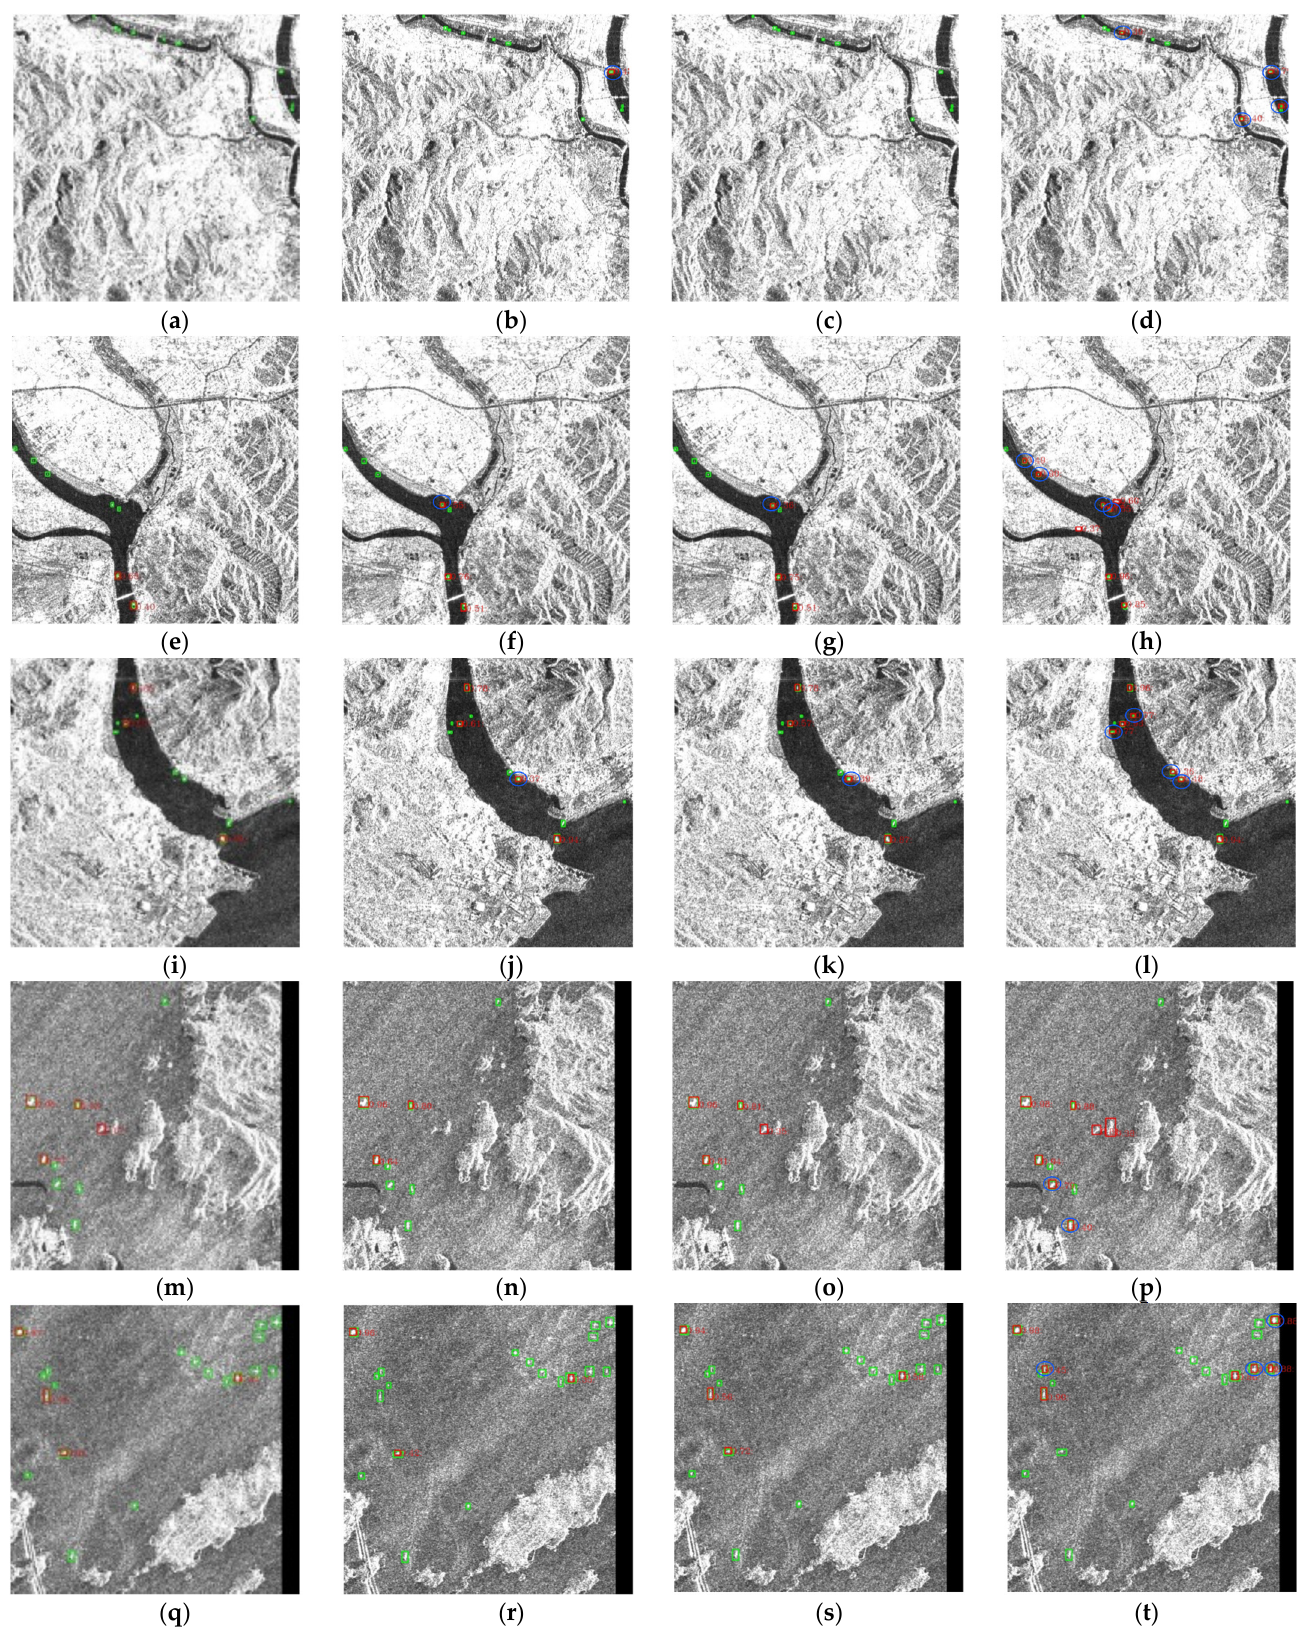
Figure 8. SAR ship detection results on LS-SSDD-v1.0. ( a , e , i , m , q ) represent the results of Faster R-CNN; ( b , f , j , n , r ) represent the results of DCN; ( c , g , k , o , s ) represent the results of Double-Head R-CNN; ( d , h , l , p , t ) represent the results of